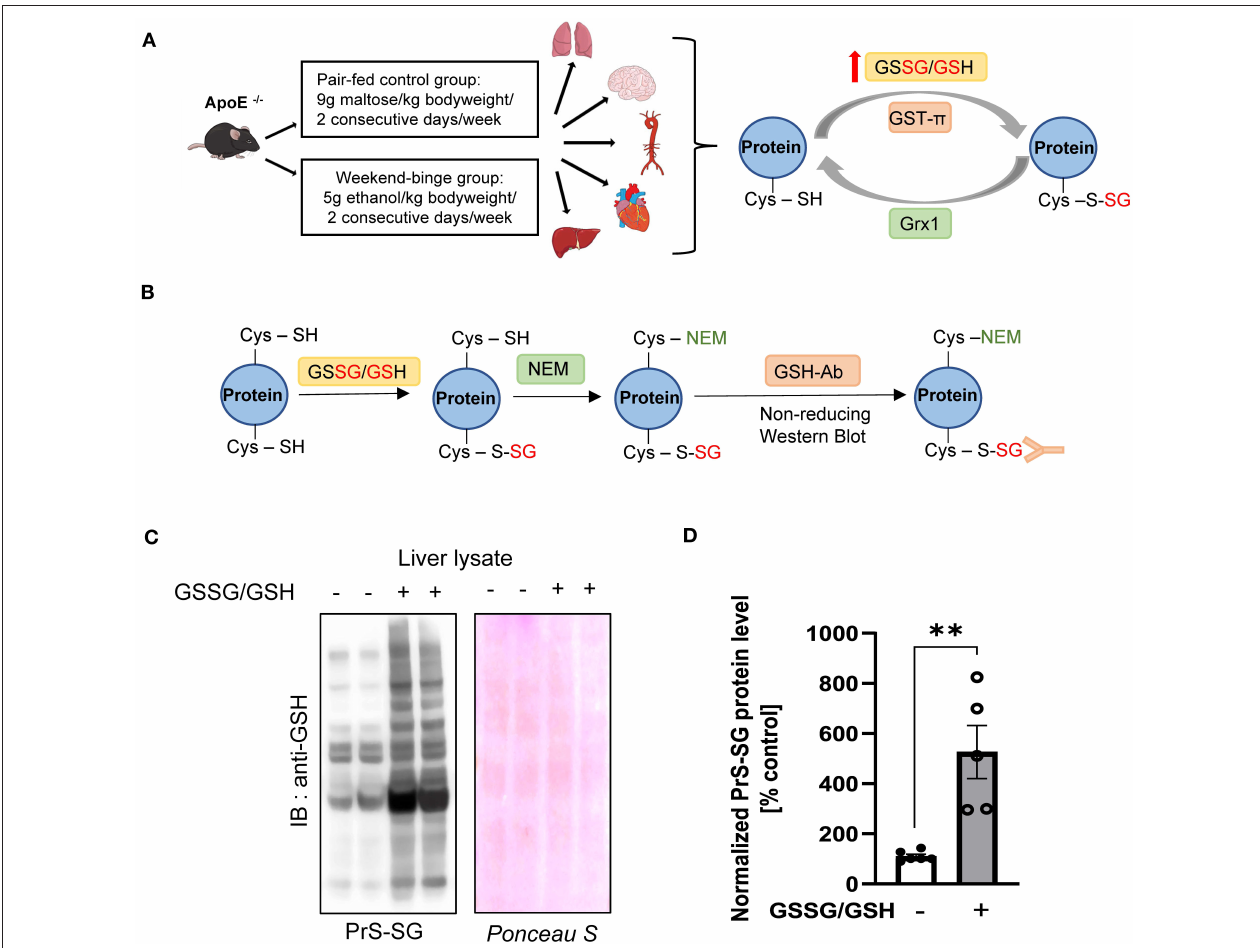
FIGURE 1 | Schematic overview of experimental setup and Validation of the GSH antibody. (A) Schematic detailing the experimental groups and analyzed tissue and simplified schematic representation of the Protein S-glutathionylation and De-glutathionylation cycle. ApoE − / − mice were fed the control Lieber-DeCarli diet ad libitum for 6 weeks and Weekend-binge (WB) group received ethanol gavages (5g/kg of body weight) for two consecutive days every week over the course of 6 weeks and the control group an isocaloric maltose dextrine solution (9 g/kg of bodyweight) respectively. After 6 weeks the mice were sacrificed and liver, heart, aorta, brain, and lung tissue harvested and analyzed for Protein S-glutathionylation (PrS-SG), Glutaredoxin1 (Grx1), and Glutathion – S – transferase π (GST- π ) expression profile. (B–D) Validation of the performance of the anti-GSH antibody. (B) Schematic representation of the experimental workflow. Liver lysate was incubated without or with GSSG/GSH on ice for 30 min and afterwards free Cysteine residues alkylated with N-Ethylmaleimide (NEM). After removing unbound GSSG/GSH/NEM the samples were subjected to 4–12% NuPAGE Bis-Tris SDS-PAGE under non-reducing conditions and immunoblot was performed with GSH antibody. (C) Representative immunoblot result and Ponceau protein staining. (D) Densitometric analysis of PrS-SG signal intensity in the liver lysate of GSSG/GSH treated samples. Bars represent mean ratio ± error propagated S.E.M. ( n = 5, Student t test, ** p -value < 0.01).